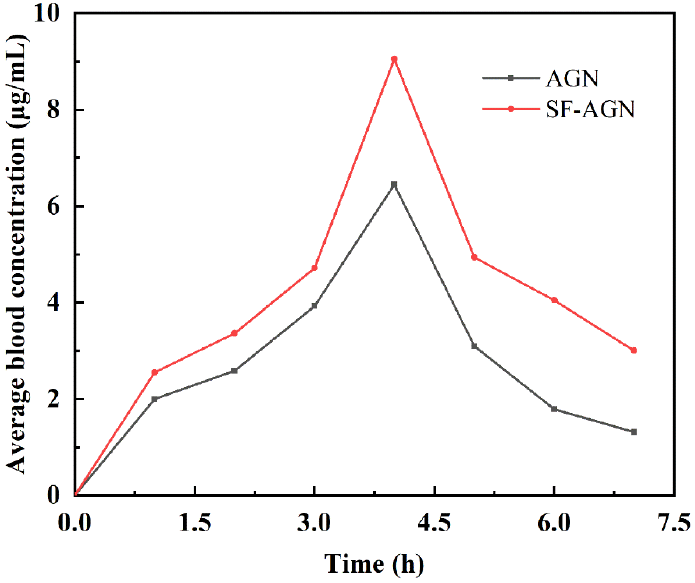
Figure 7. Drug – time curves of AGN and SF-AGN. Figure 7. Drug–time curves of AGN and